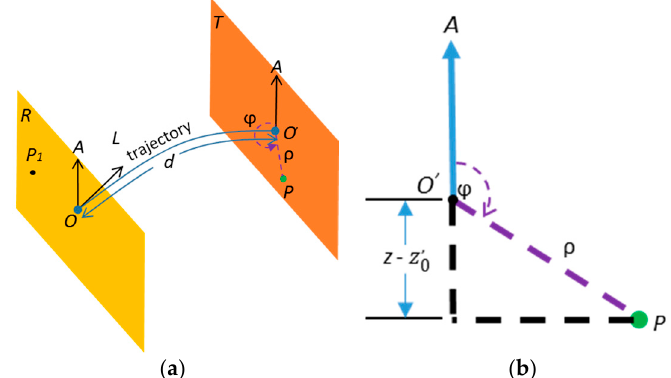
Figure 4. The cylindrical coordinate system used to compute attributes of MLS point clouds ( a ) and the computation of angular position in the polar coordinate system ( b ).